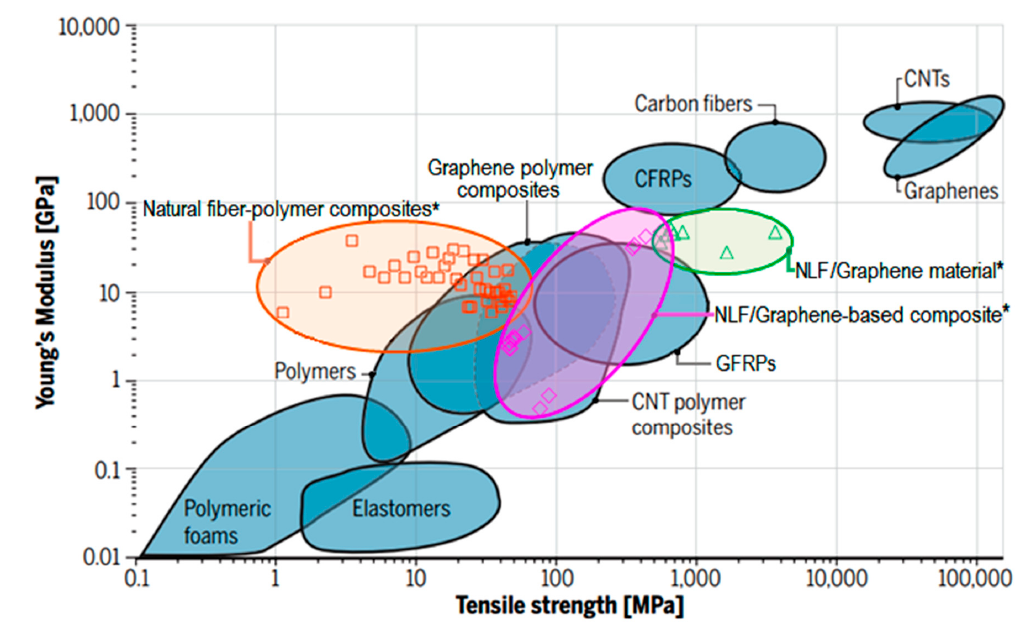
Figure 4. Ashby plot of Young’s modulus vs. tensile strength comparing the mechanical properties of natural fiber-based polymer composites* with glass fiber–reinforced plastic (GFRP) and carbon fiber–reinforced plastic (CFRP), with carbon nanotube (CNT), and graphene–based polymer composites. *The mechanical properties of natural fiber-polymer composites, natural lignocellulosic fiber (NLF) / graphene-based composites, and NLF / graphene material were based in many reported values from the literature, as shown in Table 2. Adapted from [81].